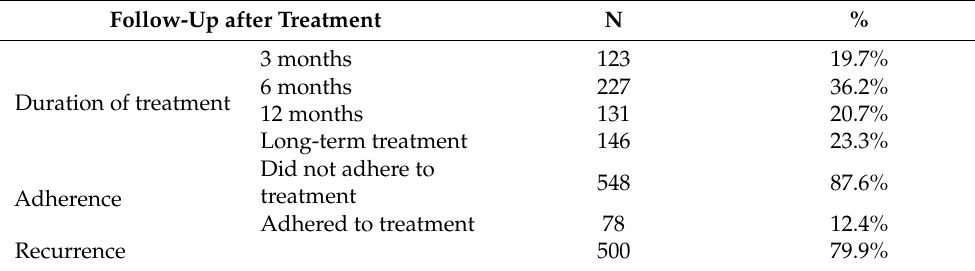
Table 4. Duration of treatment, adherence to treatment, and recurrence rate of